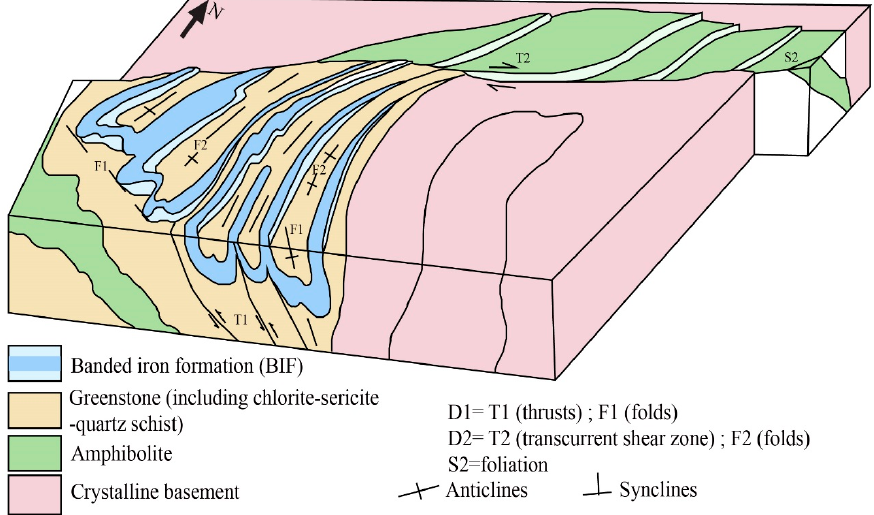
Figure 3. Structural interpretation of the Nabeba area (modified after Longley et al. [8]).